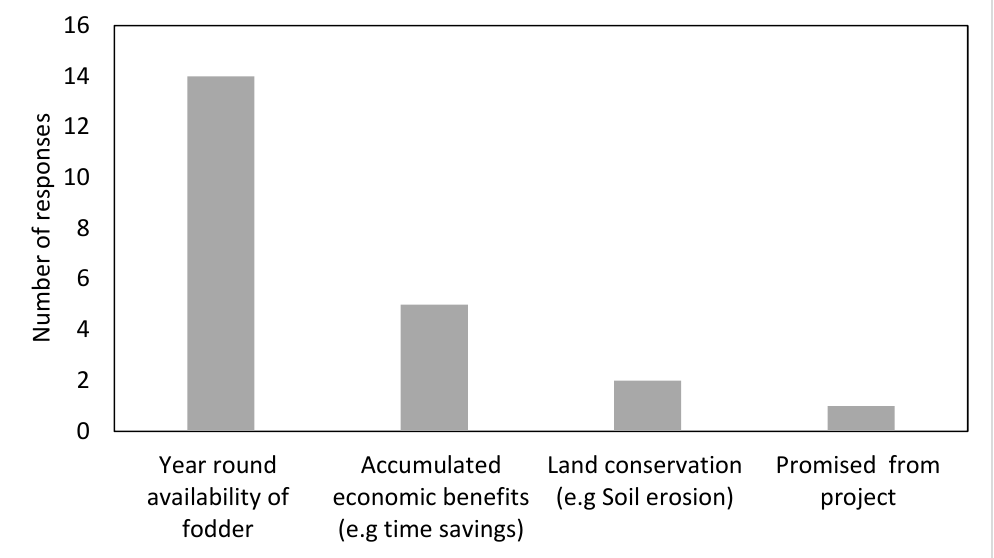
Figure 3. Reasons for sustaining the adoption of forage technologies; multiple responses possible ( n = 20).